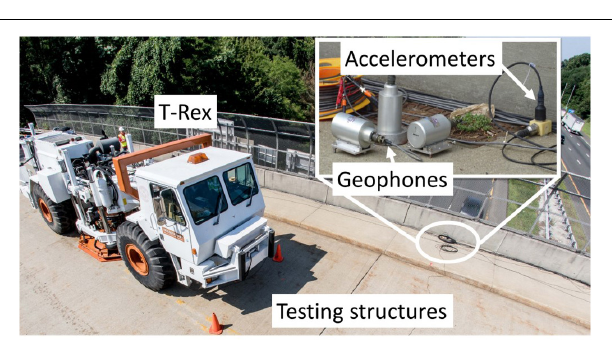
FIGURE 11 | T-Rex structural testing with 3D arrays of geophone and accelerometers.